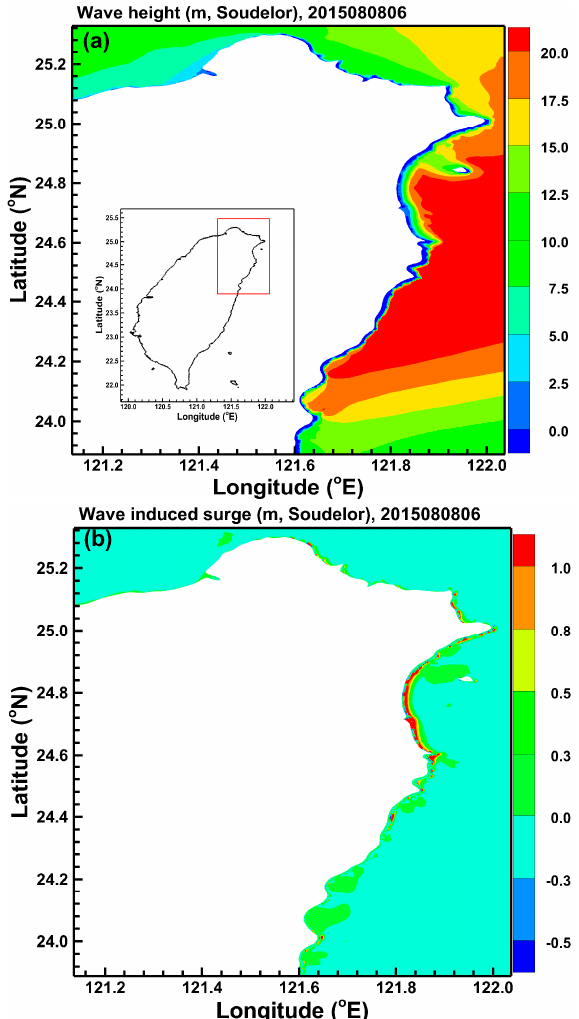
Figure 9. Spatial distribution of simulated: ( a ) wave height; and ( b ) wave-induced surge at 06:00 on 8 August 2015 for Typhoon Soudelor (2015).